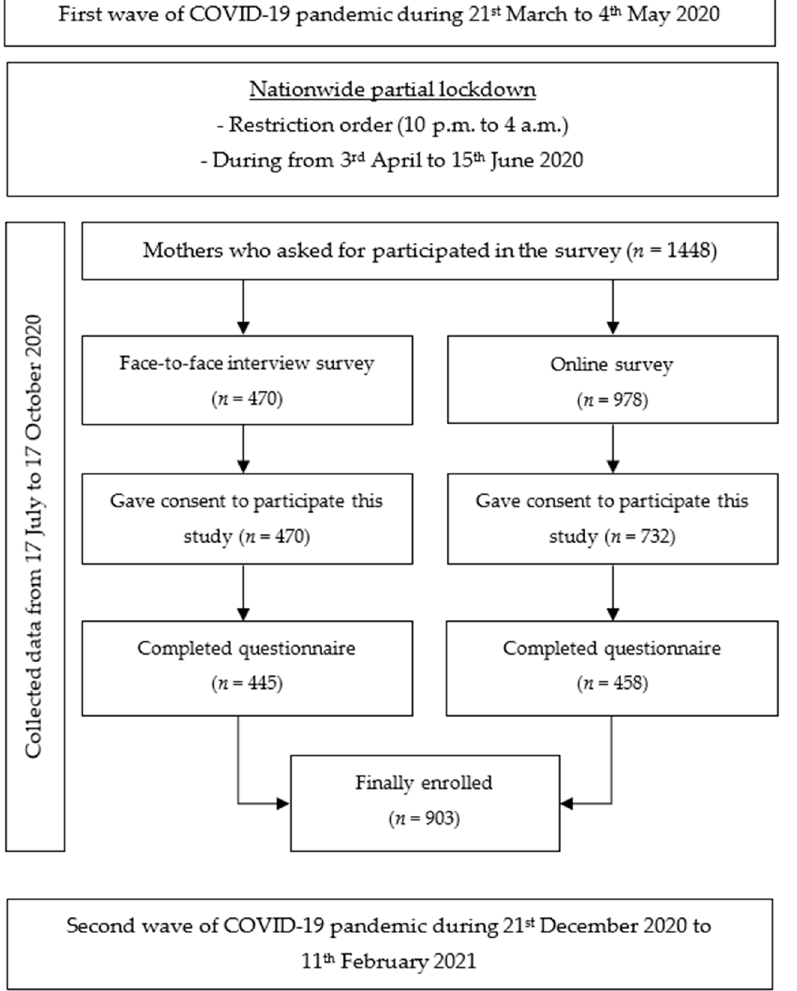
Figure 1. COVID-19 pandemic and lockdown durations in Thailand and period of the online platforms, interviews and sample size of mothers who were willing to participate in the survey.